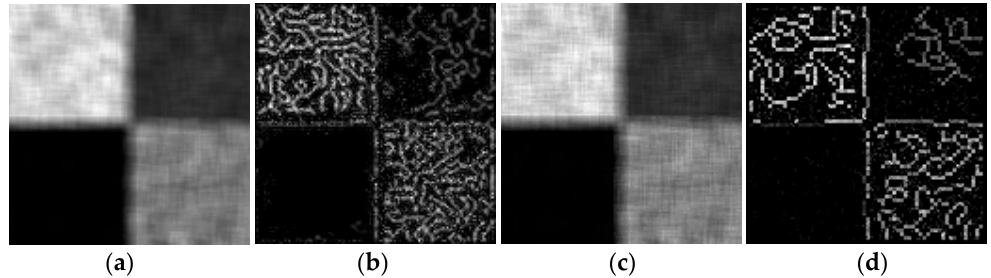
Figure 3. Texture and boundary features of a simulated SAR image: ( a ) Texture feature by using the curvelet transform, ( b ) boundary feature by using the curvelet transform, ( c ) texture feature by using the wavelet transform, ( d ) boundary feature by using the wavelet transform.